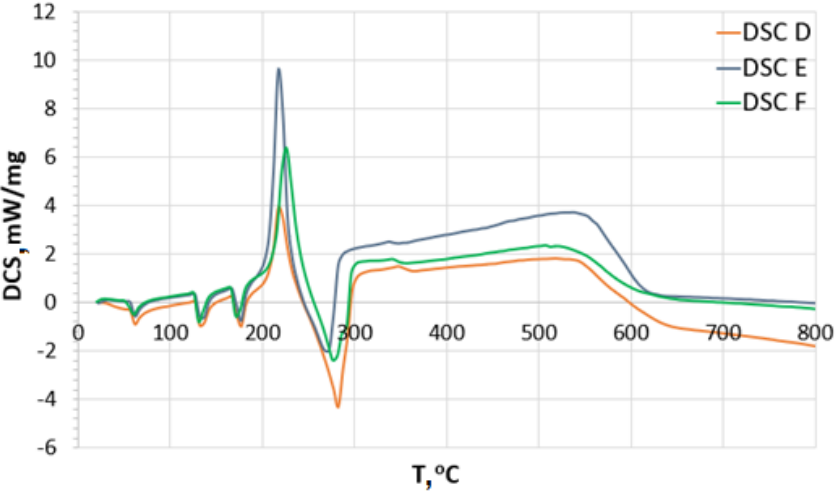
Figure 9. DSC results of explosives containing microstructure charcoal grains of 90 µ m, sample 2 (TG A), sample 3 (TG B), sample 4 (TG C).